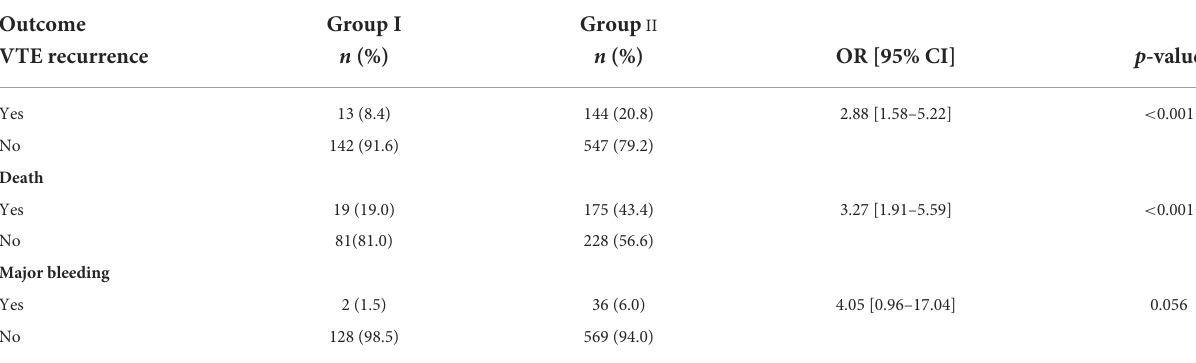
TABLE 6 Comparison between duration of Vitamin-K antagonist